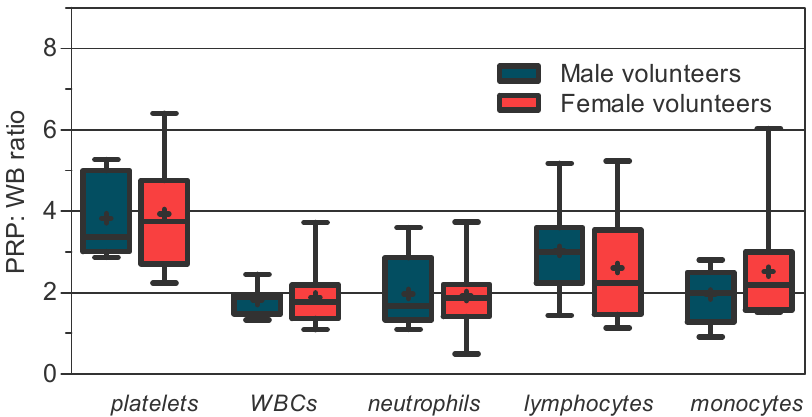
Figure 1. Increase in blood cell concentration factor (PRP/WB ratio) in male and female groups using the Easy PRP kit. Box plot: median, line in the middle of the IQR box; mean, symbol +; whiskers, minimum to maximum. Mean ( ± SD) and median [IQR] for each blood cell: For male volunteers: platelets, 3.83 ( ± 0.95) and 3.37 [1.99]; WBCs, 1.82 ( ± 0.31) and 1.89 [0.48]; neutrophils, 1.97 ( ± 0.93) and 1.67 [1.53]; lymphocytes, 3.03 ( ± 1.06) and 3.00 [1.37]; monocytes, 1.96 ( ± 0.66) and 2.00 [1.22]. For female volunteers: platelets, 3.93 ( ± 1.22) and 3.75 [2.06]; WBCs, 1.89 ( ± 0.71) and 1.77 [0.82]; neutrophils, 1.92 ( ± 0.91) and 1.86 [0.80]; lymphocytes, 2.61 ( ± 1.30) and 2.24 [2.08]; monocytes, 2.52 ( ± 1.20) and 2.19 [1.43]. Platelet and WBC counts in PRP were significantly higher than in peripheral blood in males ( p ≤ 0.01) and females ( p < 0.008) (Table 1). Counts per milliliter of platelets and total leukocytes were not significantly different between males and females (Table 1).